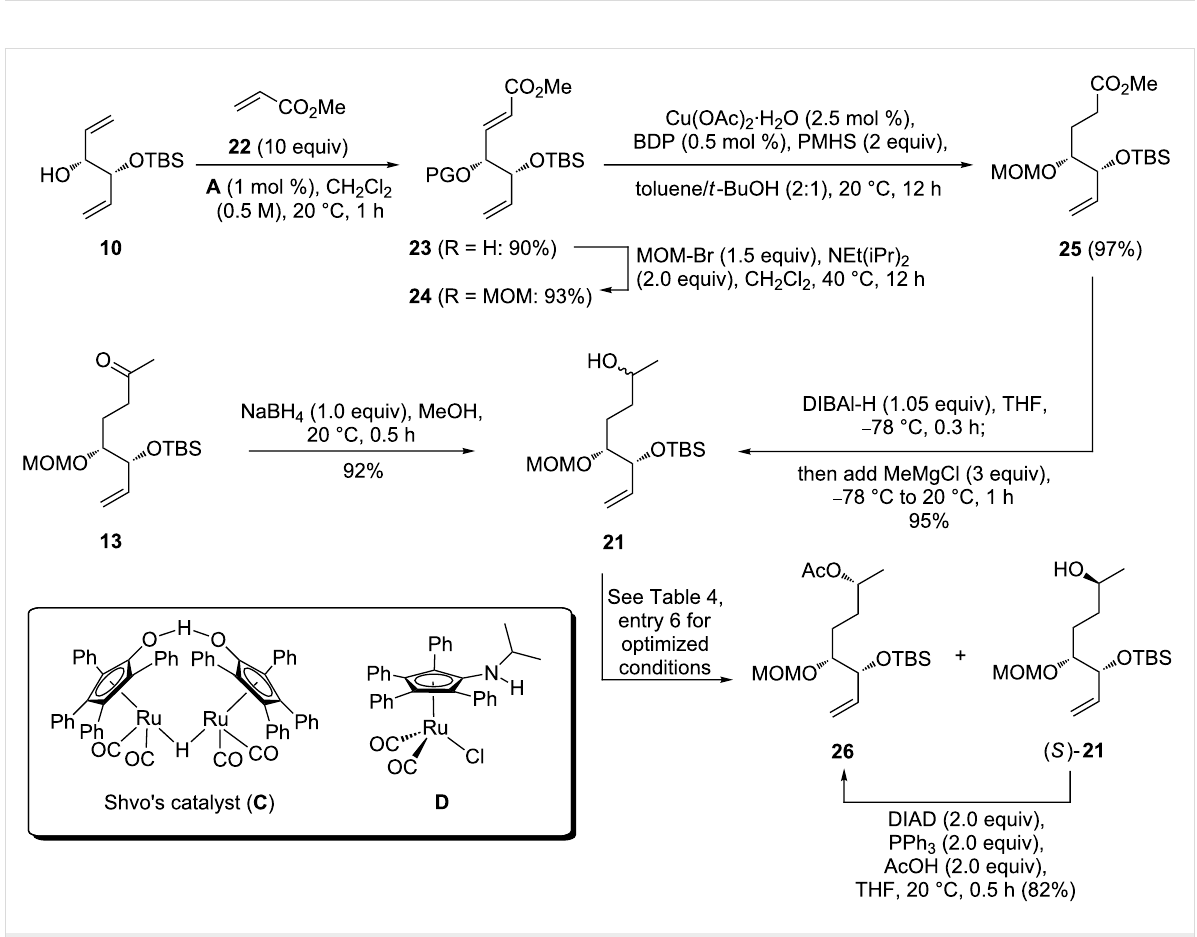
Scheme 5: Synthesis of substrate 21 for “early stage”